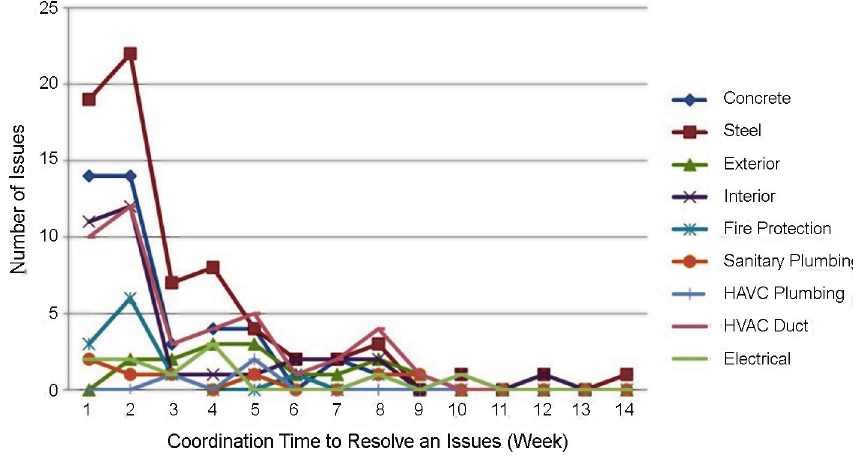
Figure 6. Coordination time to resolve issues by